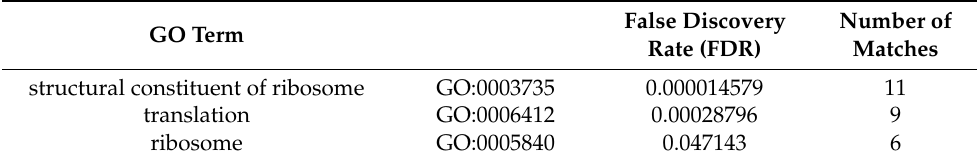
Table 3. Gene enrichment analysis of the list of 59 O. polymorpha genes.